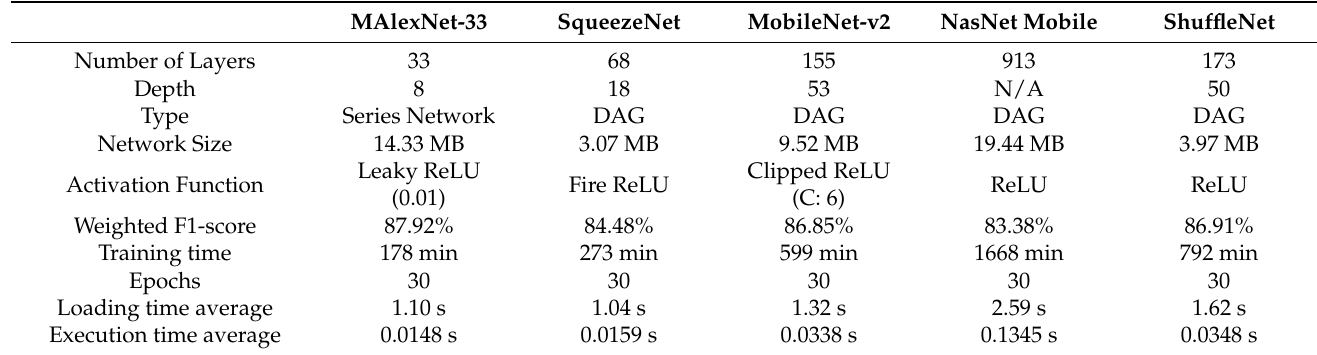
Table 9. Detailed Comparison with other Compact Neural